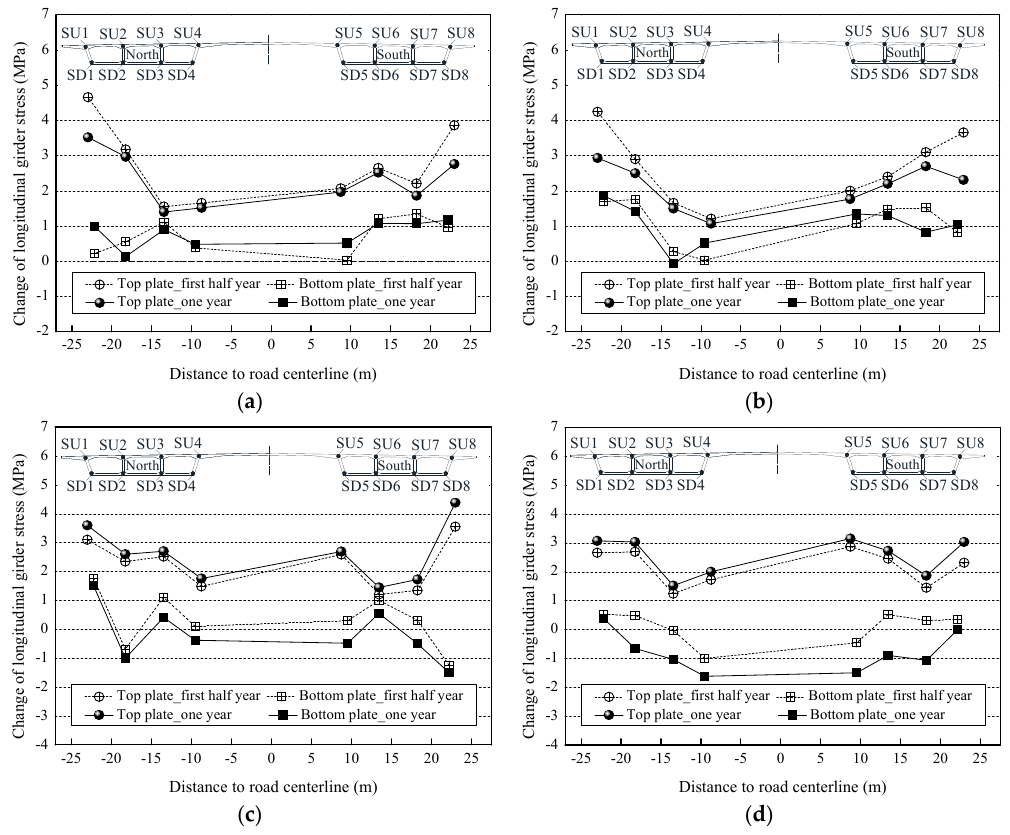
Figure 9. Measured changes of longitudinal girder stresses: ( a ) Section C2 of west side-span; ( b ) Section C12 of east side-span; ( c ) Section C5 of mid-span; and ( d ) Section C7 of mid-span.